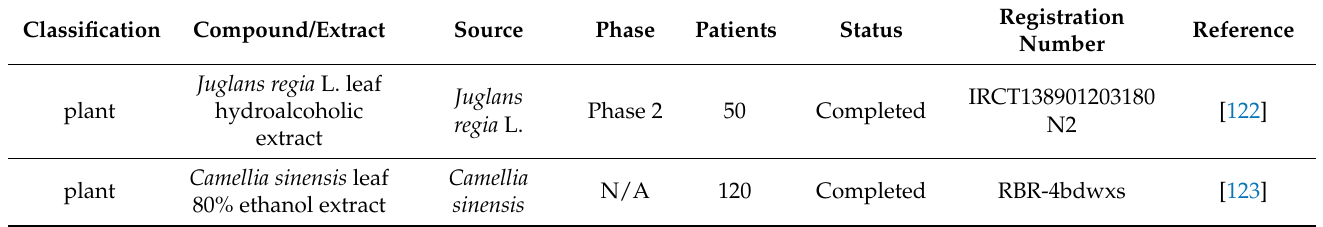
Table 8. Clinical